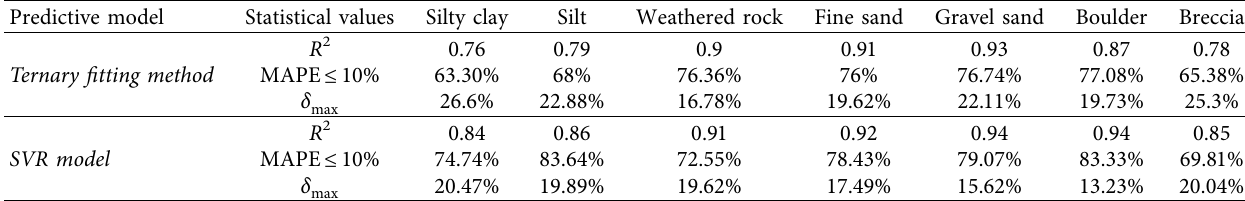
Table 4: Statistics of prediction results of the ternary fitting model and SVR model.